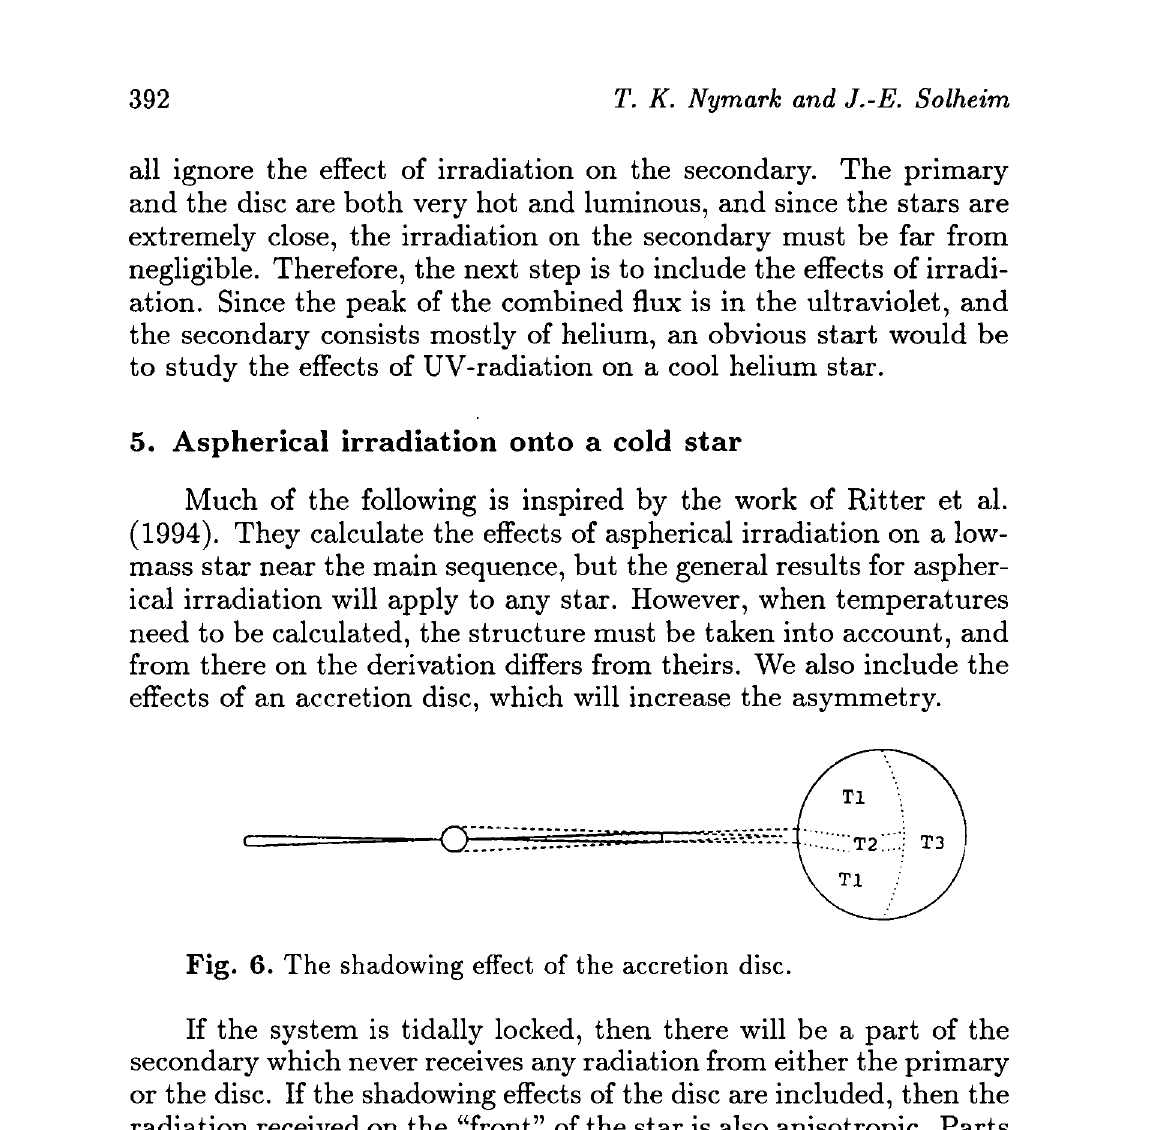
Fig. 6. The shadowing effect of the accretion